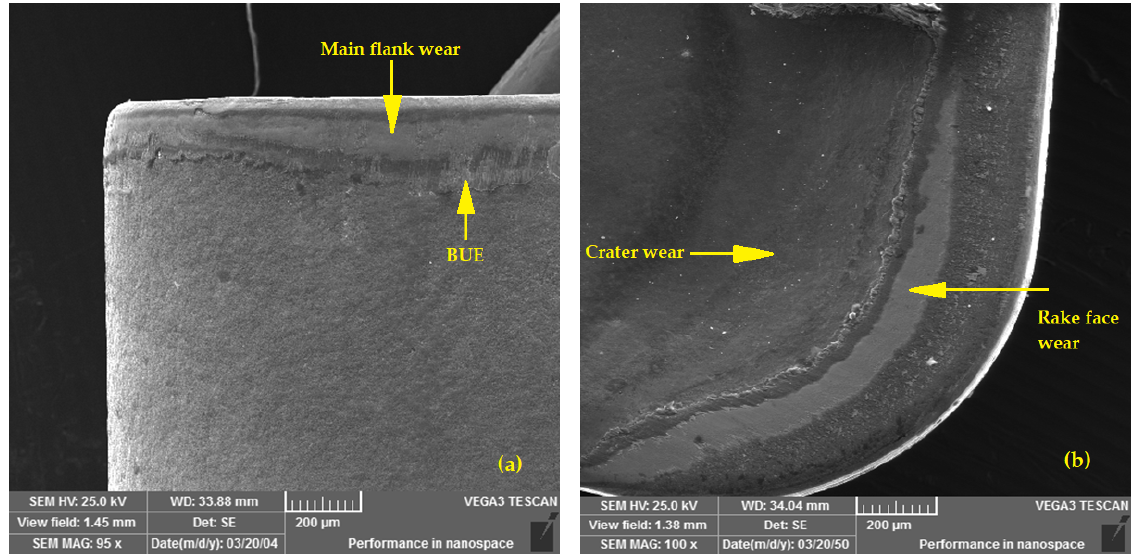
Figure 7. SEM analysis of wear of CNMG 120408-PM 4315: ( a ) main flank view, ( b ) rake face.